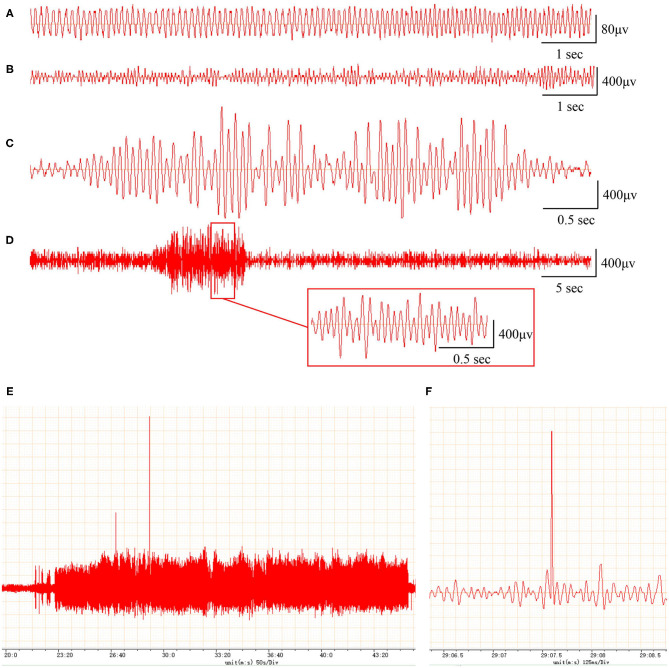
Rats with FeCl2 injection-induced post-traumatic epilepsy (PTE) showed epileptiform discharges on electroencephalogram (EEG). A total of 12 rats were randomly divided into sham and PTE groups (n = 6/group). Rats in PTE group were injected with 10-μl FeCl2 (0.4 mol/L, 1 μl/min) at right frontal cortex. Sham group underwent same procedures except for injection. A 1-h EEG, including first 15 min and blocks of 10 min at 5-min intervals, was recorded at 1 h before injection and at 1 h and 1, 7, and 30 days after injection. Representative EEGs are shown. (A) Normal EEG at 60 min before injection. Multiple spikes (B), two- and three-phase sharp waves (C), 10-s continuous abnormal discharges (D), 20-min explosive abnormal discharges with occasional high-amplitude spikes (E), and a sudden high-amplitude spike (F) were observed on day 30 after injection.